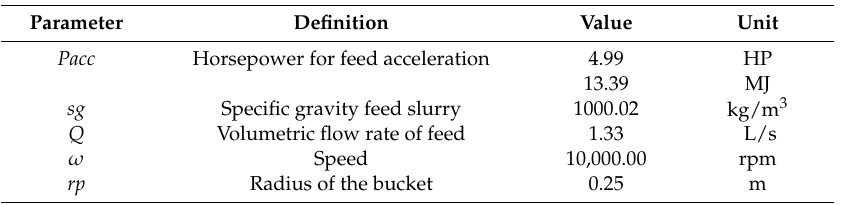
Table 4. Energy required in the centrifuge